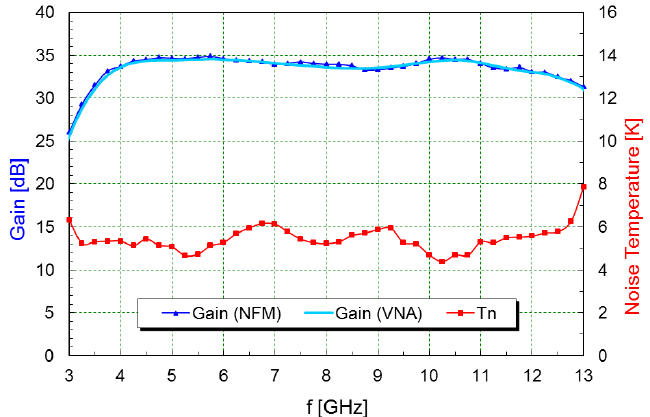
Figure 11. Gain and noise temperature plots of the X-band LNA at 14 Kelvin ambient temperature.